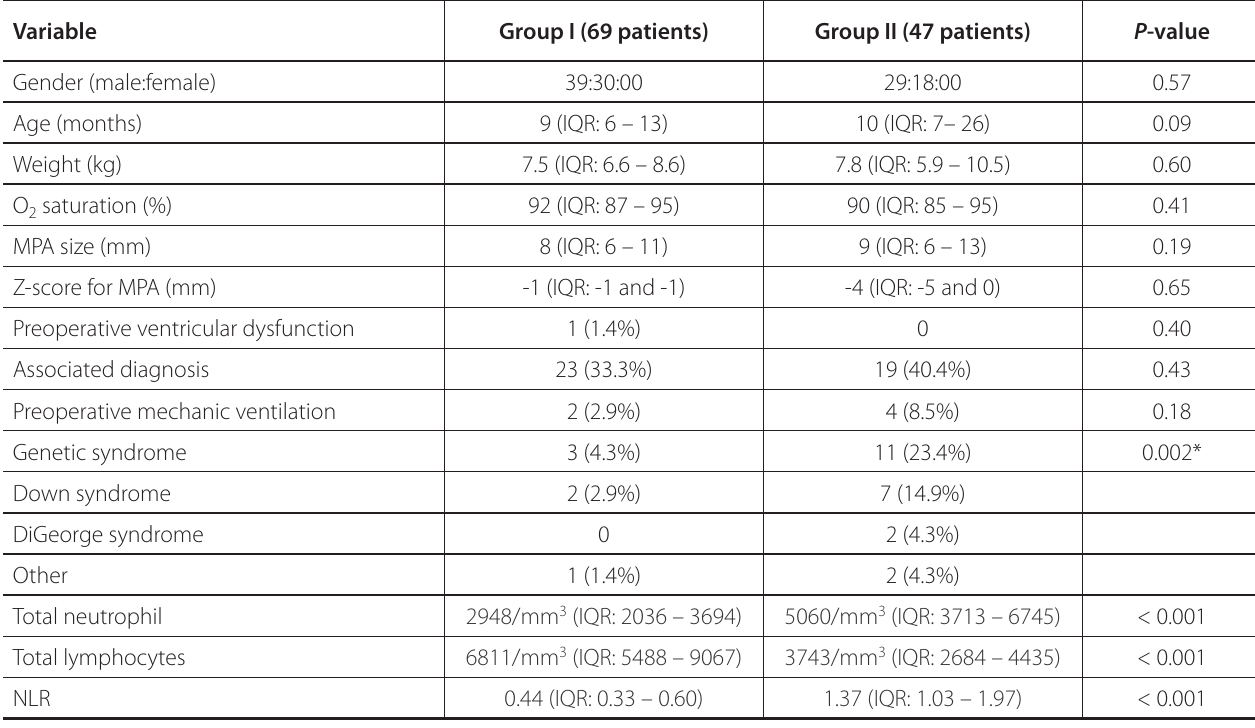
Table 1 . Baseline characteristics of 116 patients with tetralogy of Fallot who underwent surgical correction from January 2014